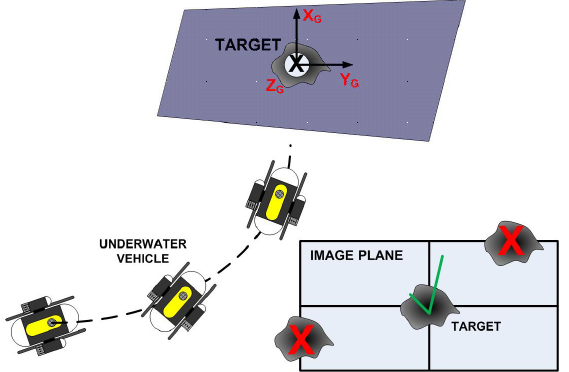
Figure 2. Navigation and stabilization in front of a visual target while maintaining the visual target within the camera’s Field of View (FoV), c (cid:13) 2014 IEEE